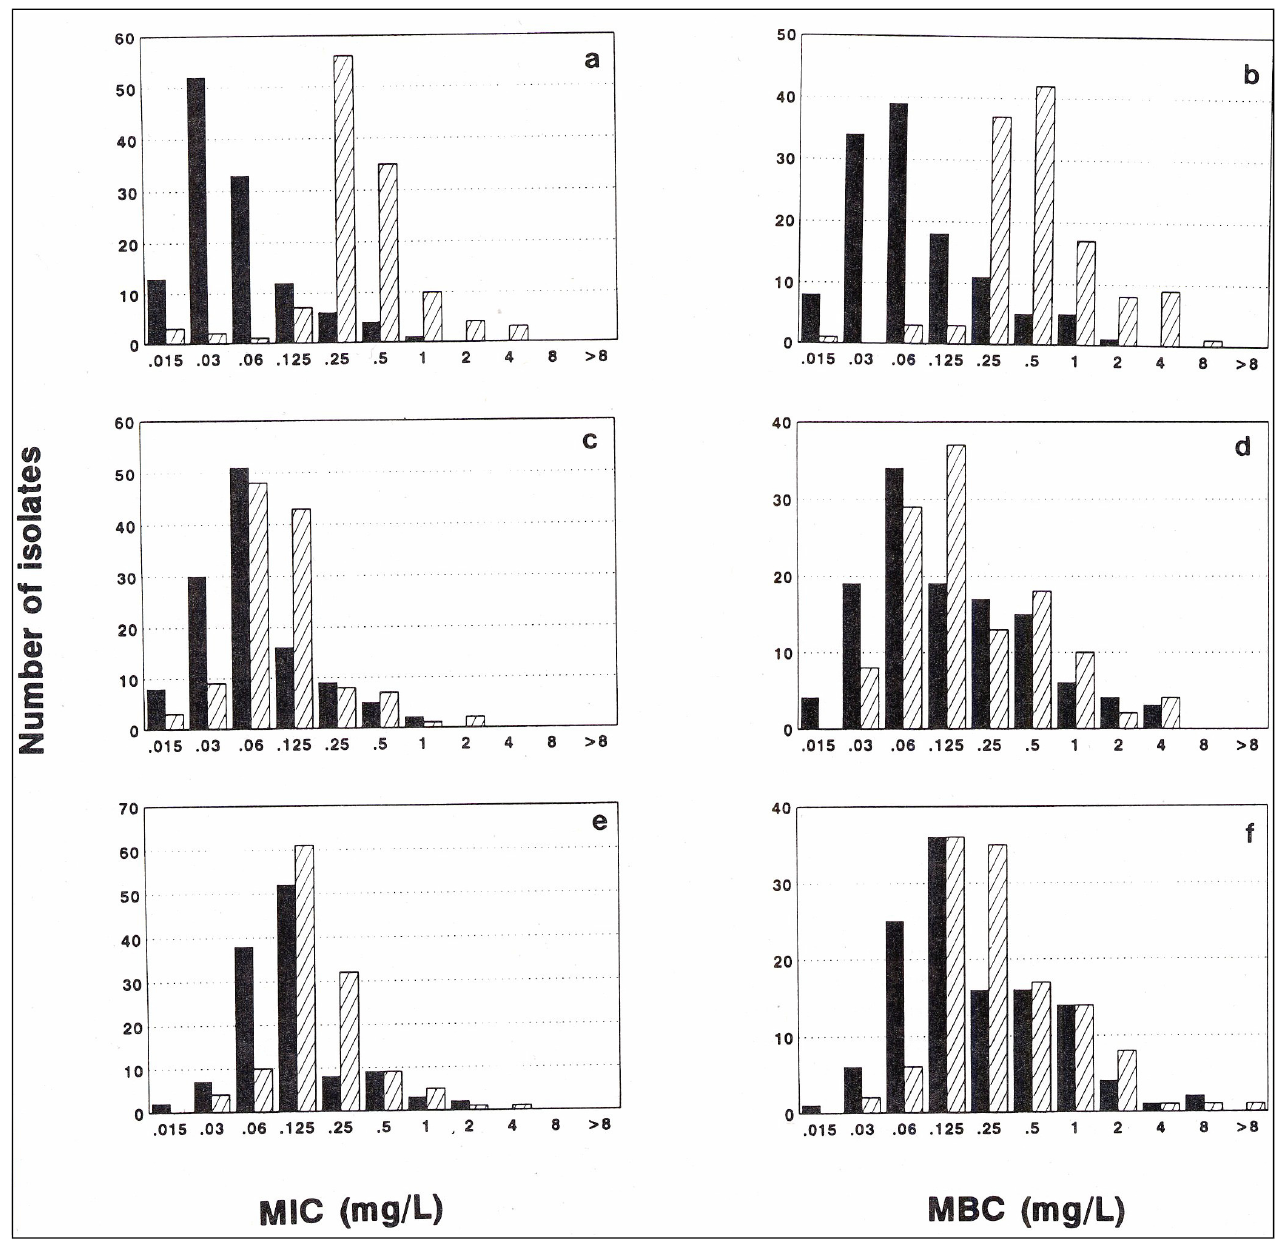
Fig ure 1) Fre quency dis tri bu tion of mini mum in hibi tory con cen tra tions (MICs) and mini mum bac te ri cidal con cen tra tions (MBCs) (mg/L). All or gan - isms were tested against cef tri ax one (MIC, MBC; a, b), ce fo taxime (MIC, MBC; c, d), and ce fo taxime/de sace tyl ce fo taxime (MIC, MBC; e, f). Solid bars: in vi tro test ing in broth with out se rum al bu min; hatched bars: in vi tro test ing in broth with 95% equiva lent se rum al bu